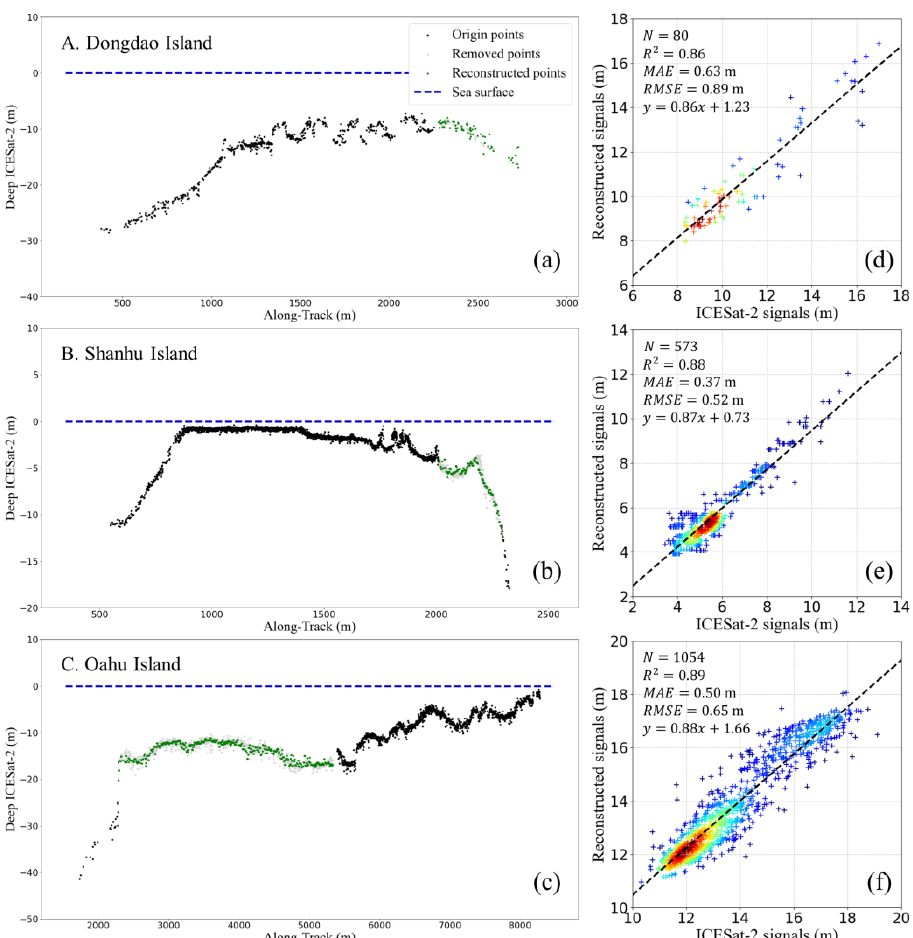
Figure 6. ( a – c ) Along-track point cloud profile after bathymetric signal reconstruction. The black points are the signals that have not been removed, the gray points are the manually deleted signals in the original data, the green points are the reconstructed signals obtained by the proposed re- construction method, and the blue dashed line indicates the sea surface. ( d – f ) The scatterplots of the reconstructed signals versus the original ICESat-2 signals in these three study areas.